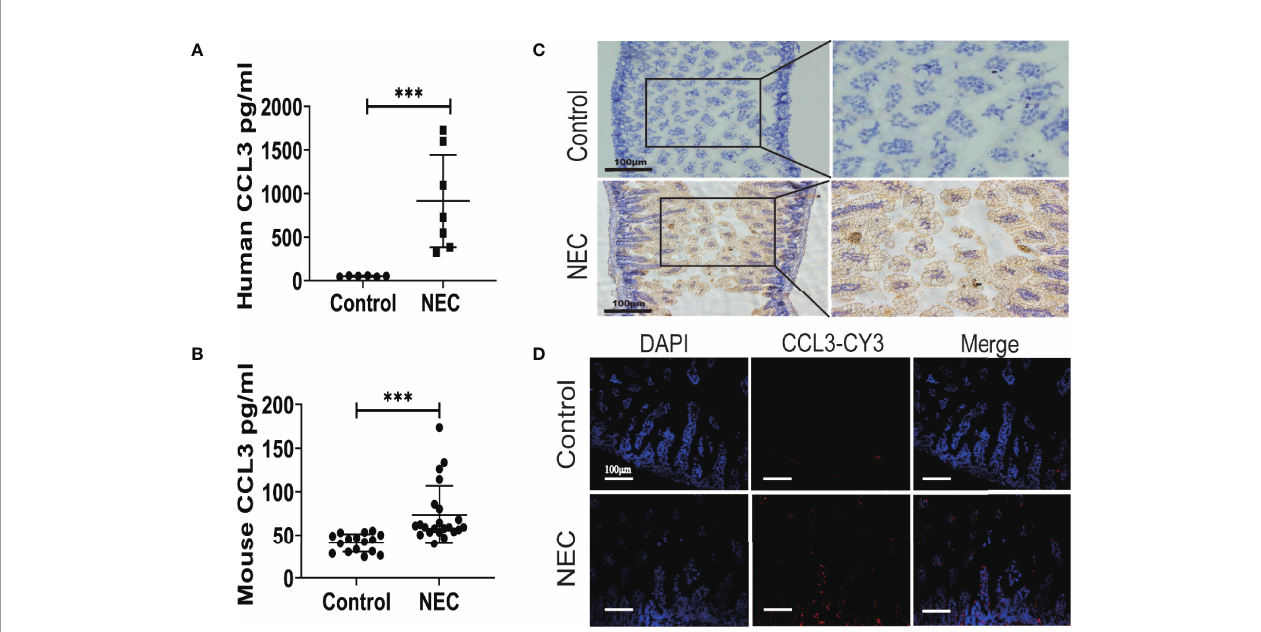
FIGURE 1 | The Expression of CCL3 in the intestine necrotic lesions of patient and mice. ELISA was used to detect the concentration of CCL3 in intestinal tissue lysates from (A) . clinical patients and (B) . model mice and their corresponding control groups. Data are expressed as mean ± SD and were analyzed using the nonparametric Mann-Whitney U test. ***p < 0.001 versus Control or NEC groups. (C) . Immunohistochemistry was used to detect CCL3 in paraf fi n sections of mouse intestinal tissue (DAB chromogenic, Scale bar=100 m m). (D) Immuno fl uorescence was used to detect CCL3 (CY3-Tyramide, red) in paraf fi n sections of mouse intestinal tissue as indicated (Scale bar=100